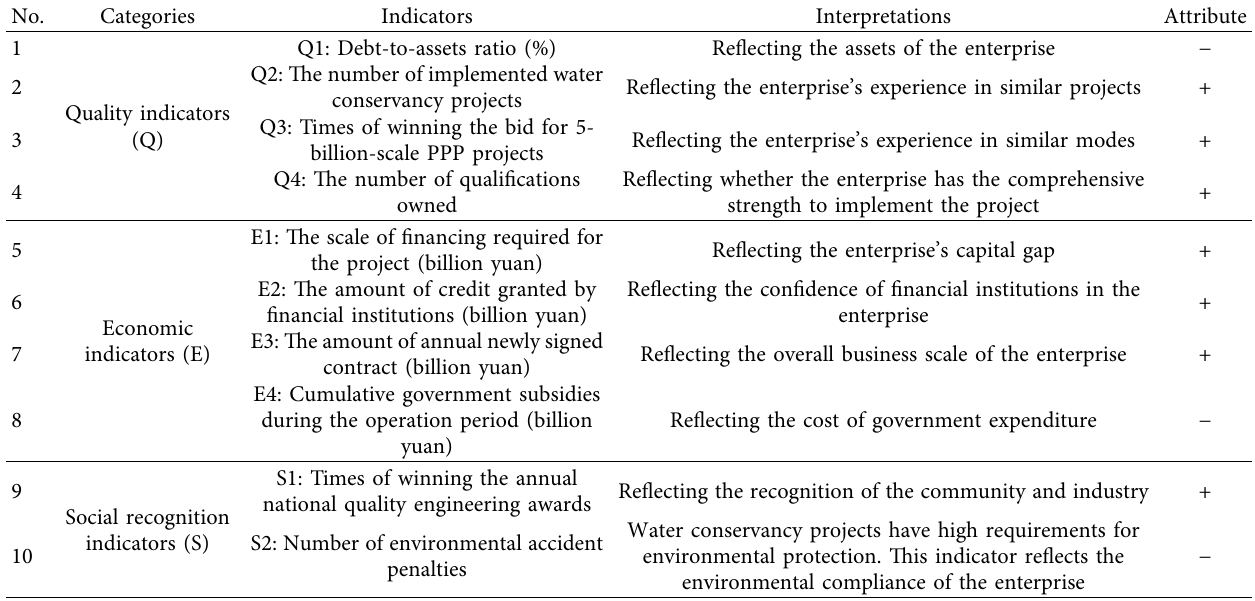
Table 2: The evaluation indicator system of each alternative enterprise and interpretations.